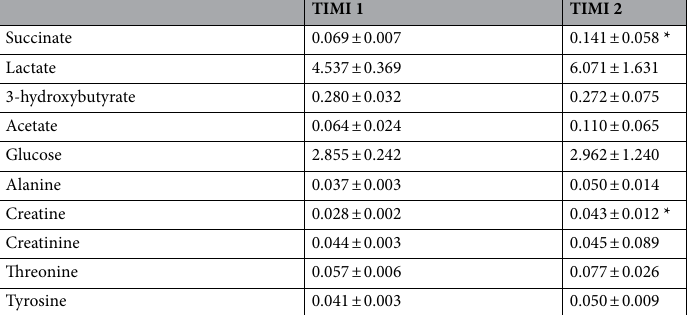
Table 2. Concentrations of selected metabolites (mmol/L) analyzed by 1 H NMR spectroscopy in plasma extracts obtained from peripheral blood samples in STEMI patients with initial TIMI flow 1 as compared with data from those with initial TIMI flow 2. * ( p < 0.05) indicates significant differences versus TIMI 1